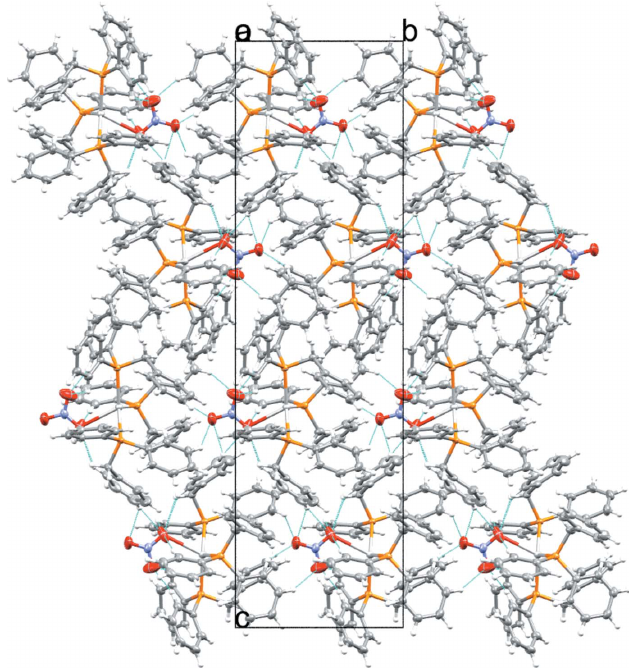
Figure 2 Packing diagram as viewed along the a axis of the structure of the title compound. Non-classical hydrogen-bonding interactions are indicated with cyan dotted lines.